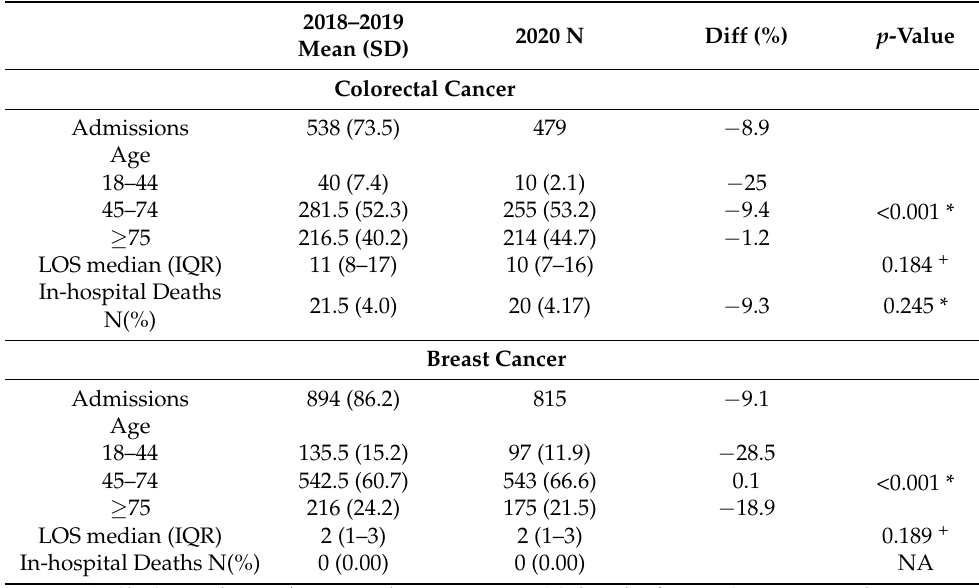
Table 1. Comparison of admissions that occurred between the last ten months of 2020